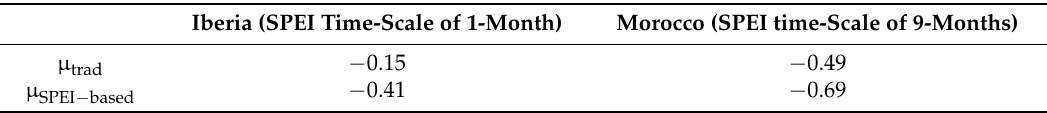
Table 2. Comparison of the metric µ when using the traditional rationale to estimate VHI ( µ trad ) and the SPEI-based method to estimate VHI ( µ SPEI − based ) for the two regions of interest.